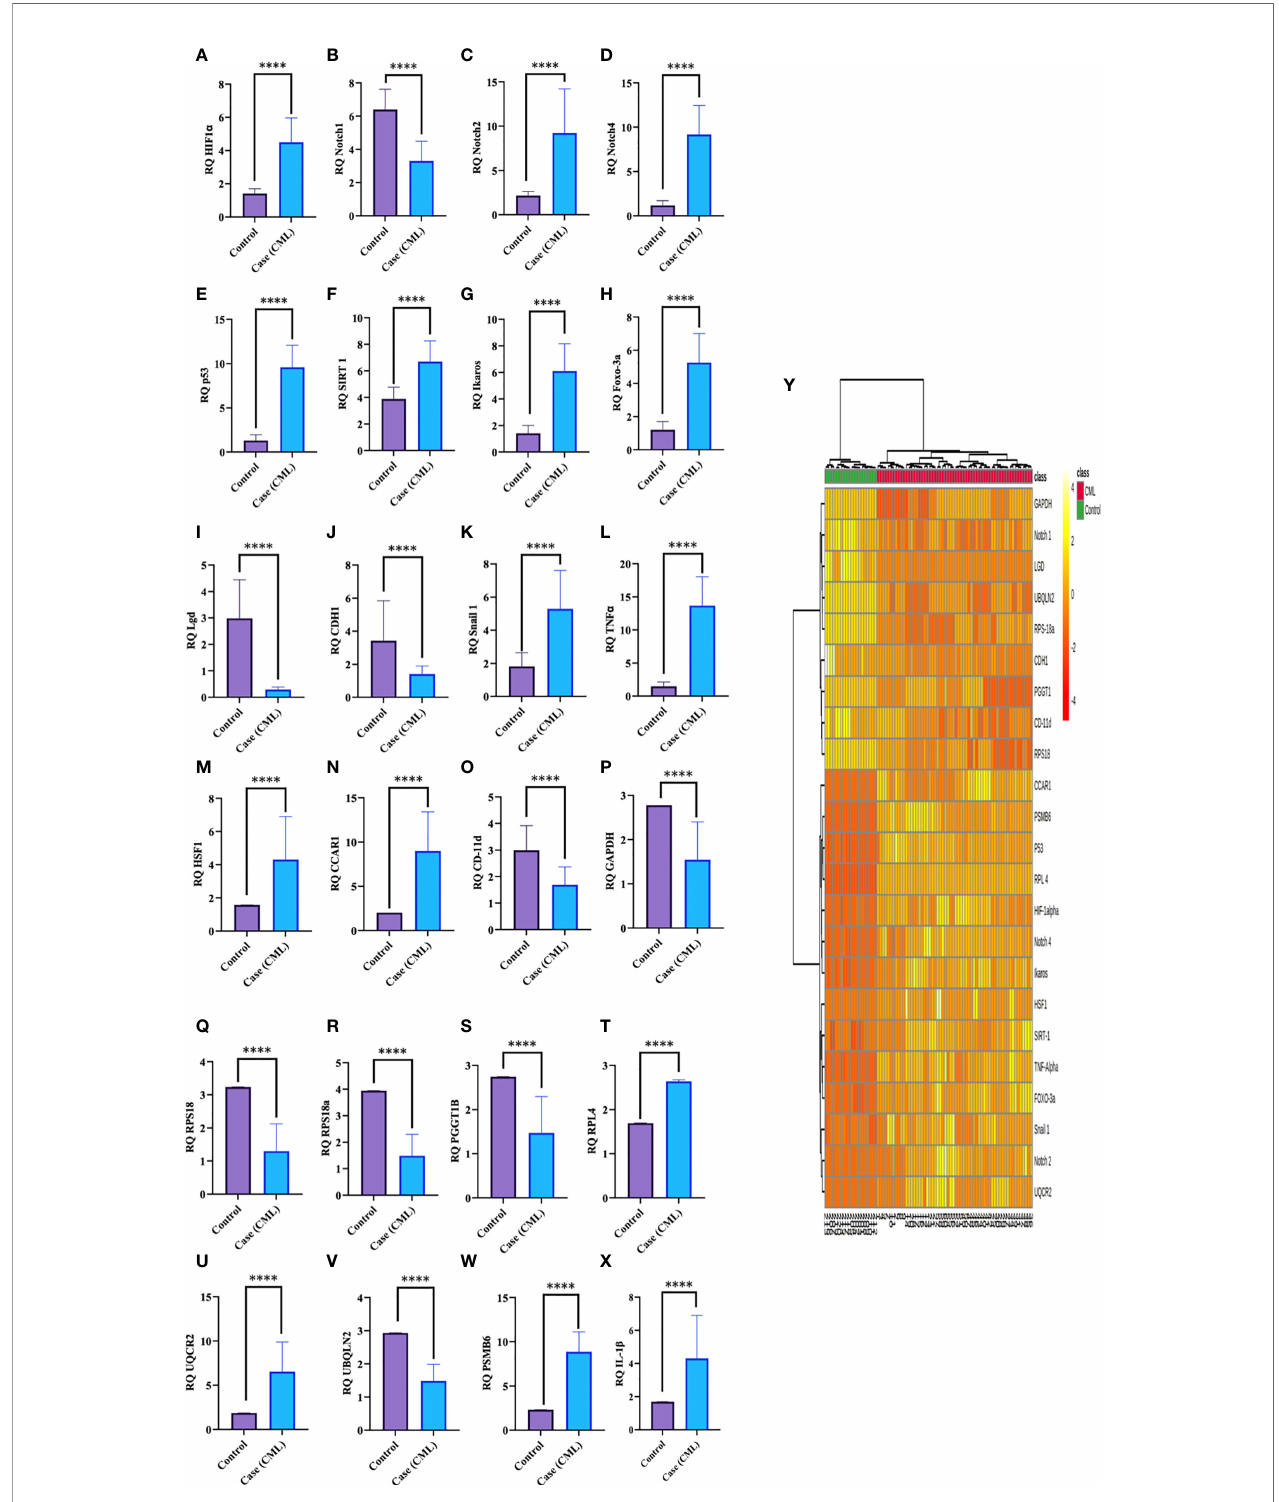
FIGURE 4 | Gene expression of HIF1 a , Notch1, and their associated genes in CML. (A – X) Gene expression was quanti fi ed by RT-PCR in CML (n = 60) and healthy controls (n = 20), where HIF1 a and its associated genes were found to be upregulated and Notch 1 was downregulated in blast crisis cells of CML patients. (Y) The heat map shows the relative expression of all the genes in CML (class indicated Control and CML), and the intensity of color shows the expression of genes. All quantitative data are the mean ± SD, ****p<0.00001, Student ’ s t-test